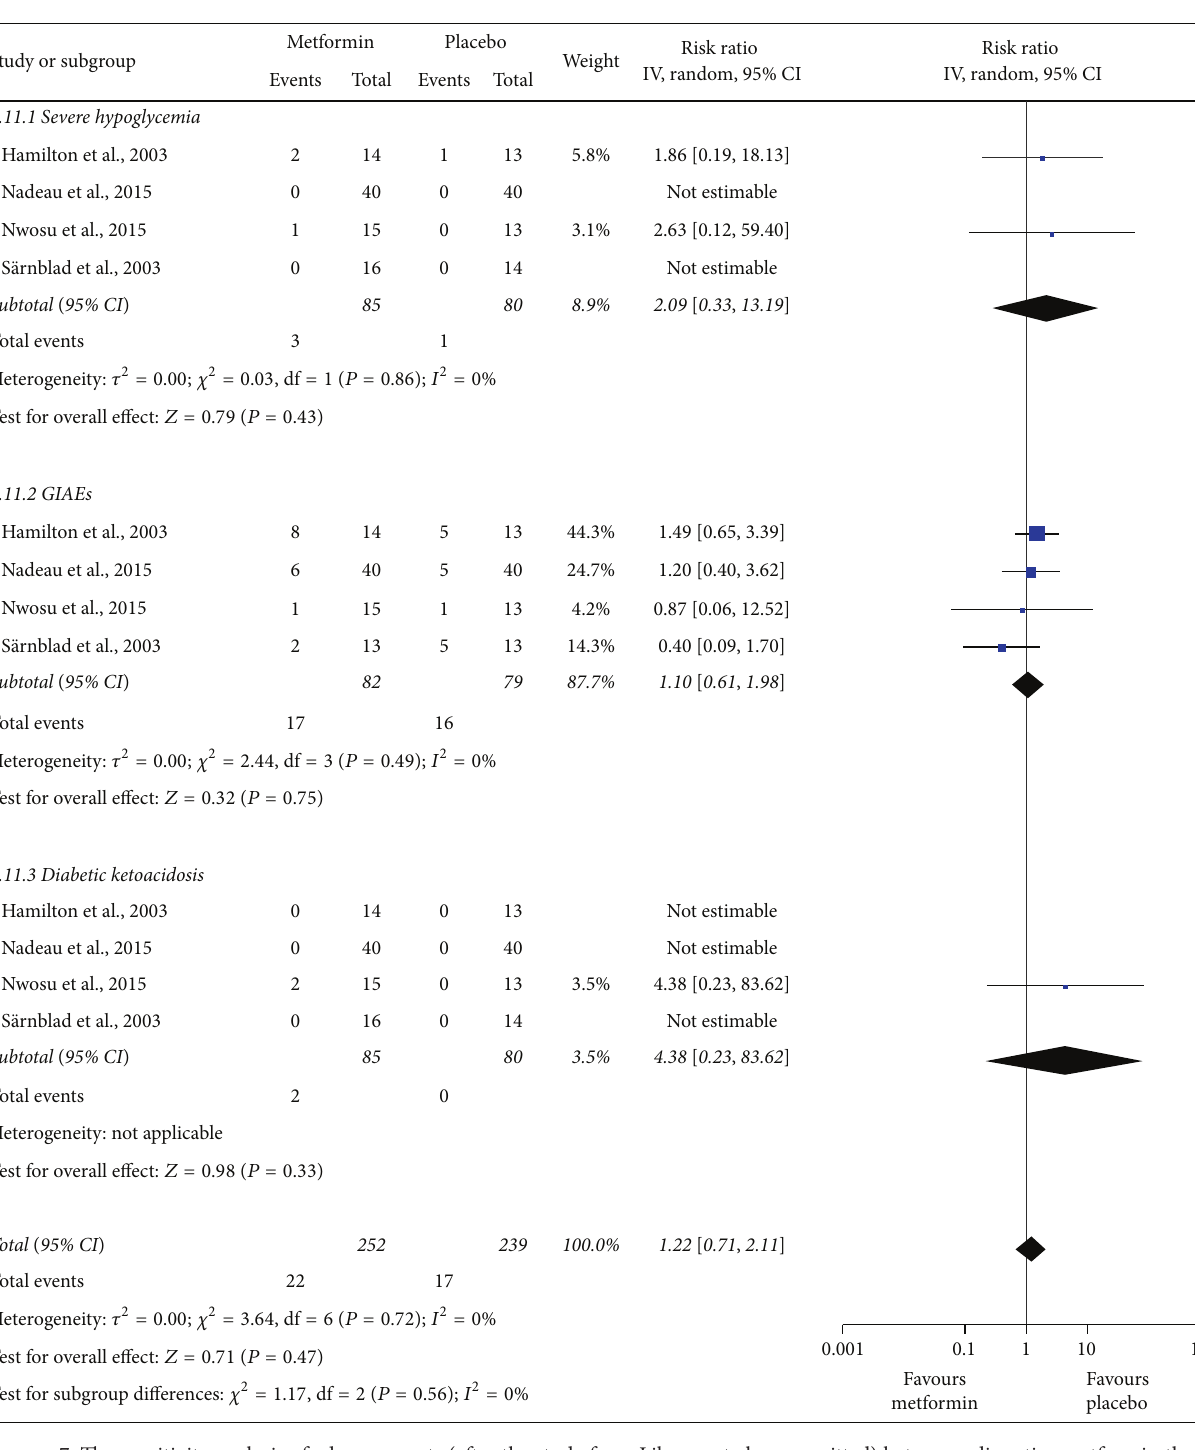
Figure 7: The sensitivity analysis of adverse events (after the study from Libman et al. was omitted) between adjunctive metformin therapy and placebo in adolescents with type 1 diabetes mellitus. CI: confidence interval; GIAEs: gastrointestinal adverse events; IV: inverse